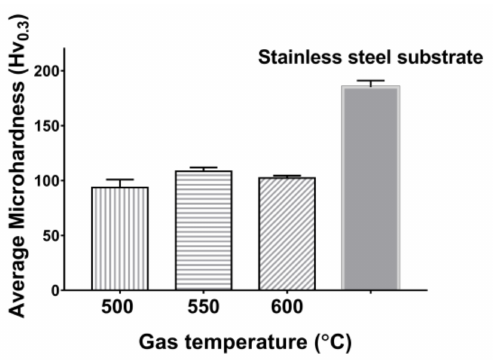
Figure 7. Microhardness of AZ91D coatings deposited at different